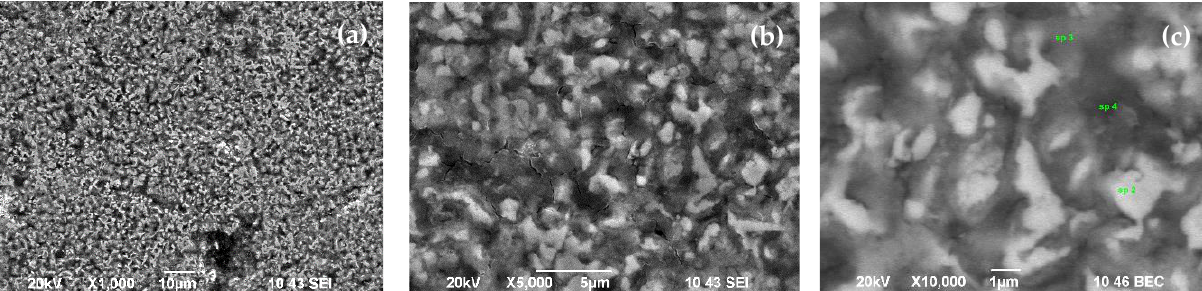
Figure 5. Secondary electron images (SEI) ( a , b ) and backscattered electron composition (BEC) ( c ) of the sample treated at 650 °C.